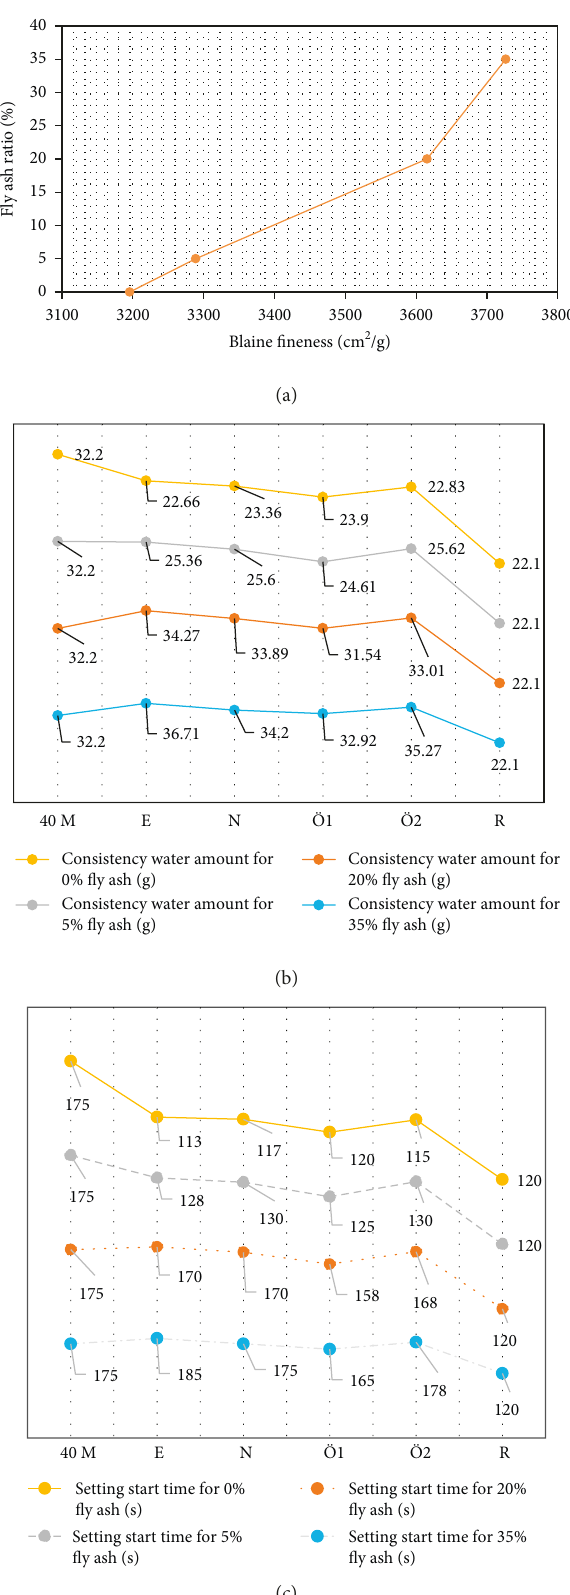
Figure 1: (a) Effect of fly ash ratio on Blaine fineness. (b) Effect of fly ash ratio on consistency water amount. (c) Effect of fly ash ratio on setting start time